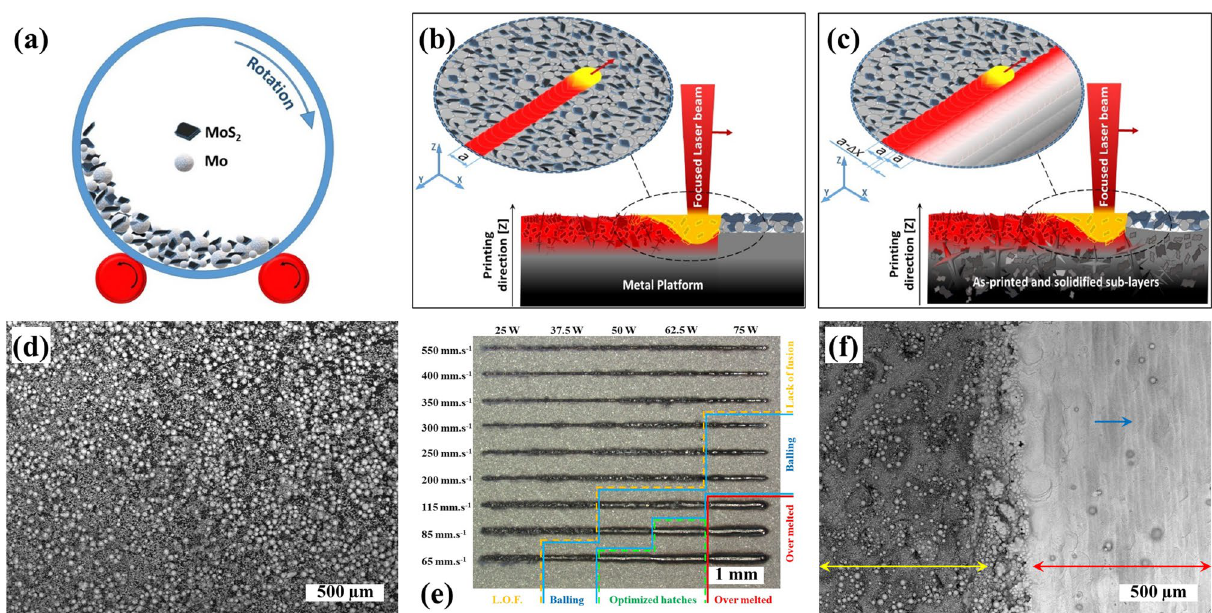
Figure 6. Schematic illustrating the (a) mixing of Mo and MoS 2 powders, (b) single laser scanning, and (c) laser-based fusion of the powder bed with partial remelting of the previously solidified layer. (d) SEM images of a homogenous mixture of Mo and MoS 2 powders, (e) stereomicrograph of laser single scan as a function of energy density, and (f) SEM image of the half-melted sample showing the boundary between the melted/ solidified (red arrow), un-melted powder bed (yellow arrow), and hatch overlap during continues single laser scanning of powder bed (blue